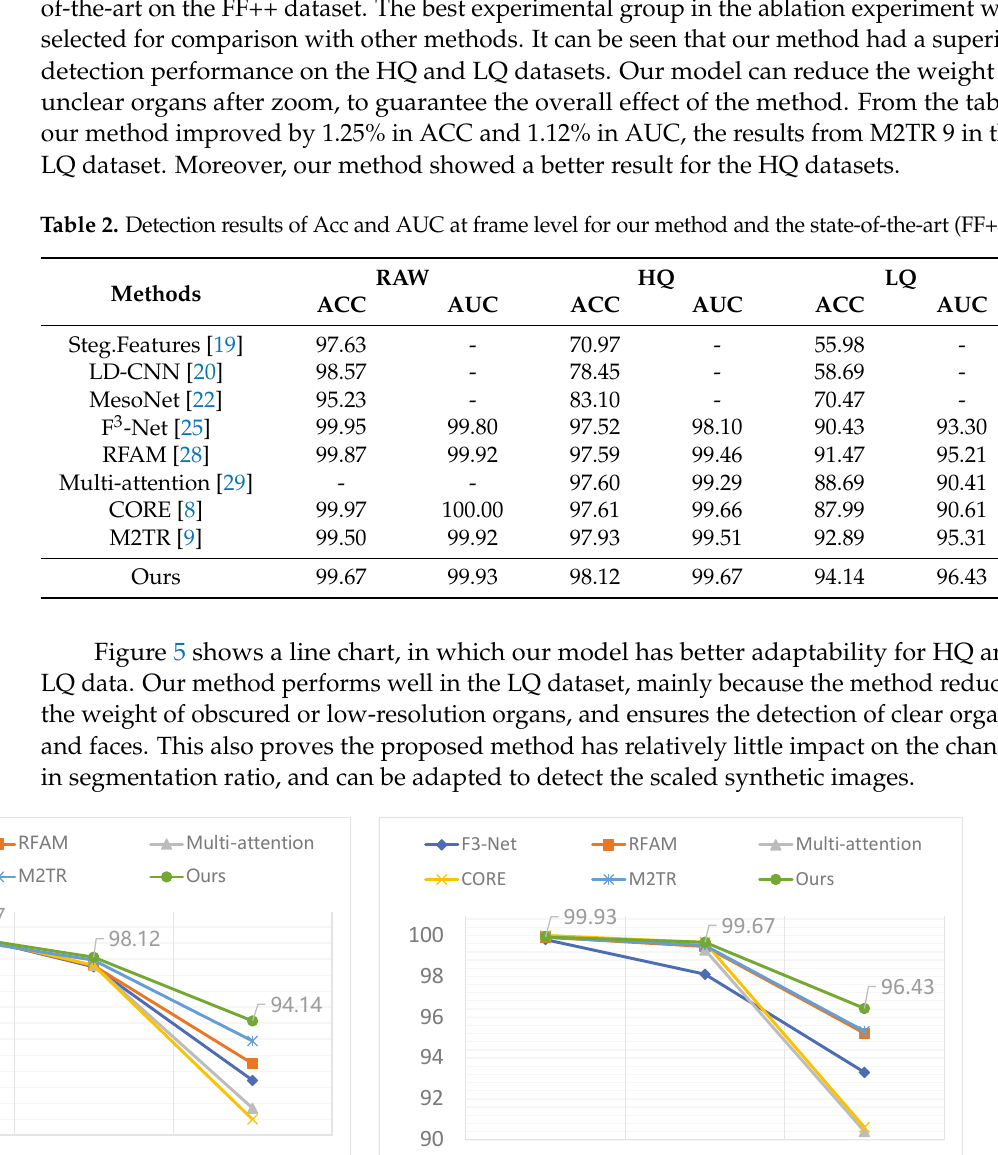
Figure 5. The line chart of ACC and AUC in the RAW, HQ, and LQ dataset.